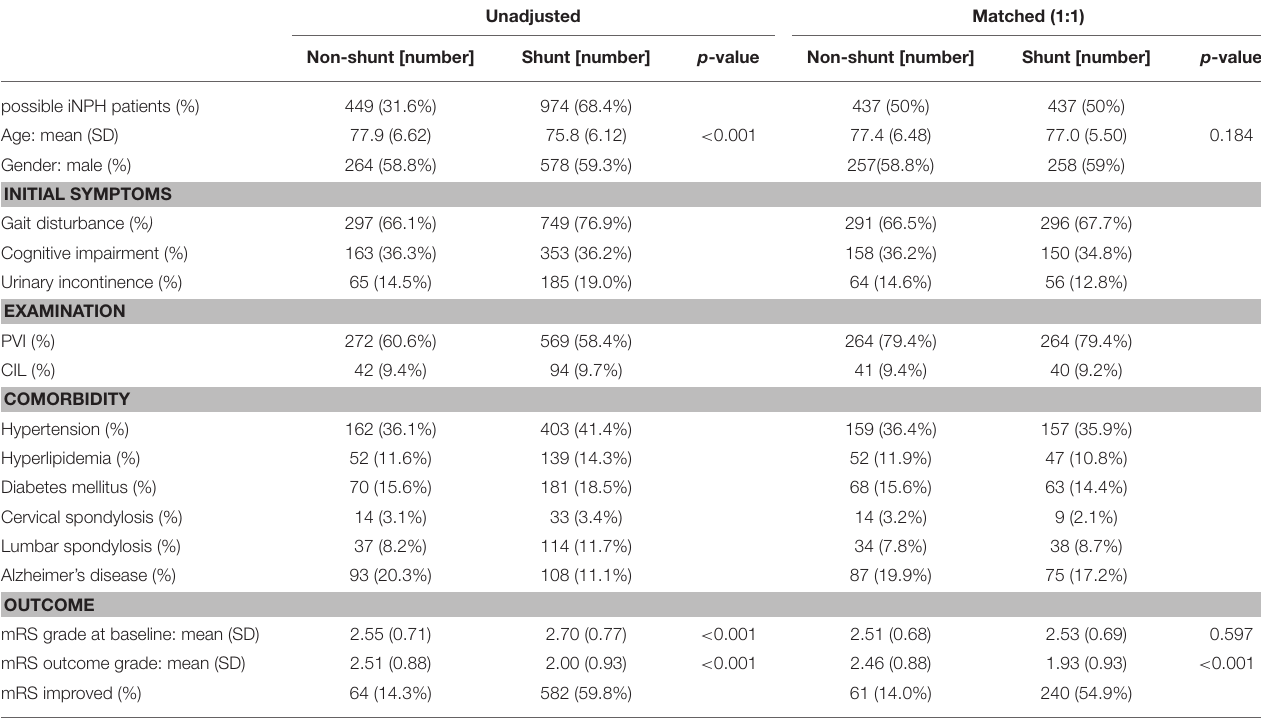
TABLE 1 | Baseline characteristics of 1,432 patients with or without shunt intervention in idiopathic normal pressure